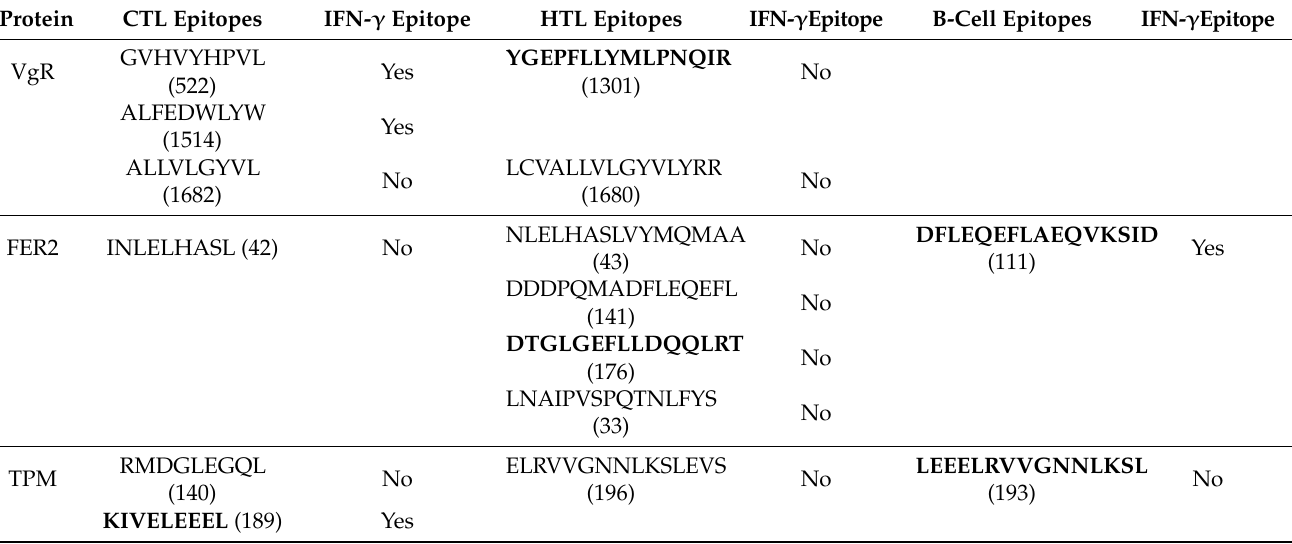
Table 3. Final shortlisted selected